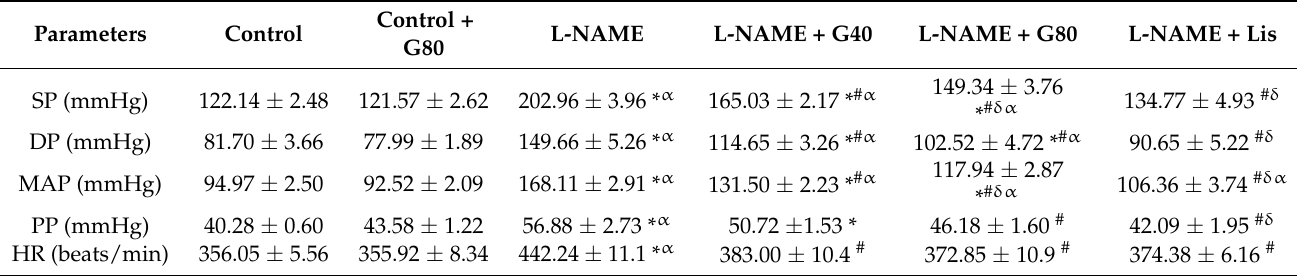
Table 2. Effects of genistein on hemodynamic parameters in L-NAME-induced hypertensive